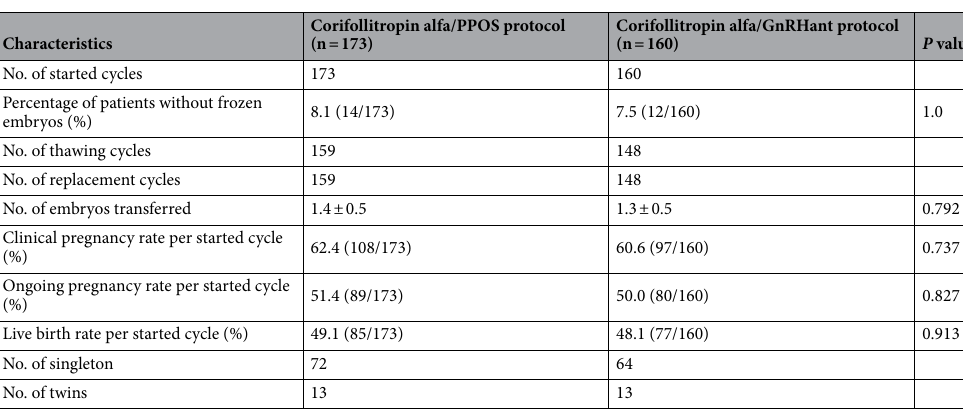
Table 3. Clinical outcomes of first frozen embryos transfer cycle. Values are expressed as number, mean ± standard deviation or percentage. PPOS progestin primed ovarian stimulation, GnRHant GnRH